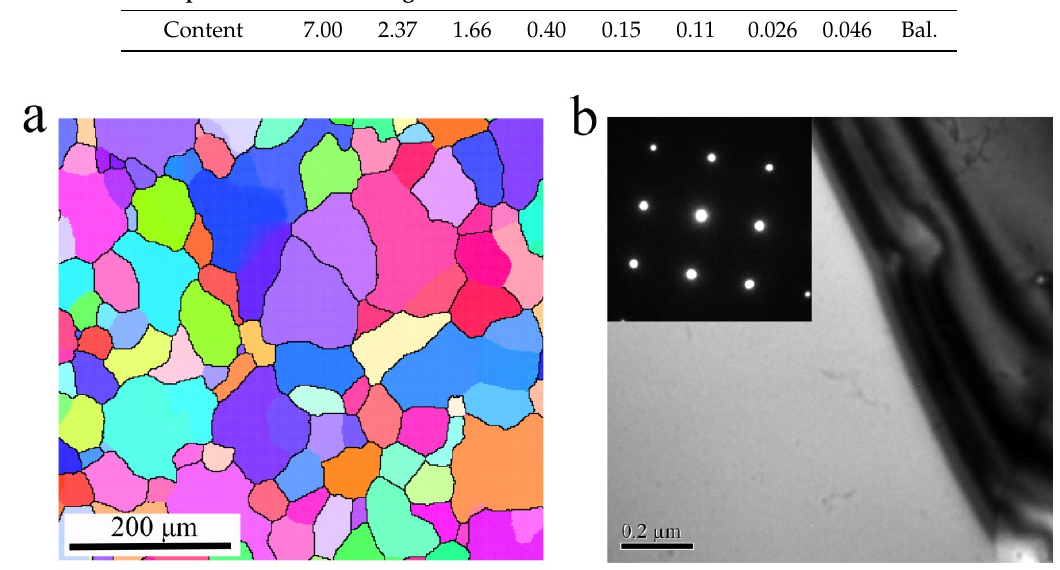
Figure 1. Microstructures of the homogenized Al-Zn-Mg-Cu alloy: ( a ) EBSD and ( b ) TEM images.